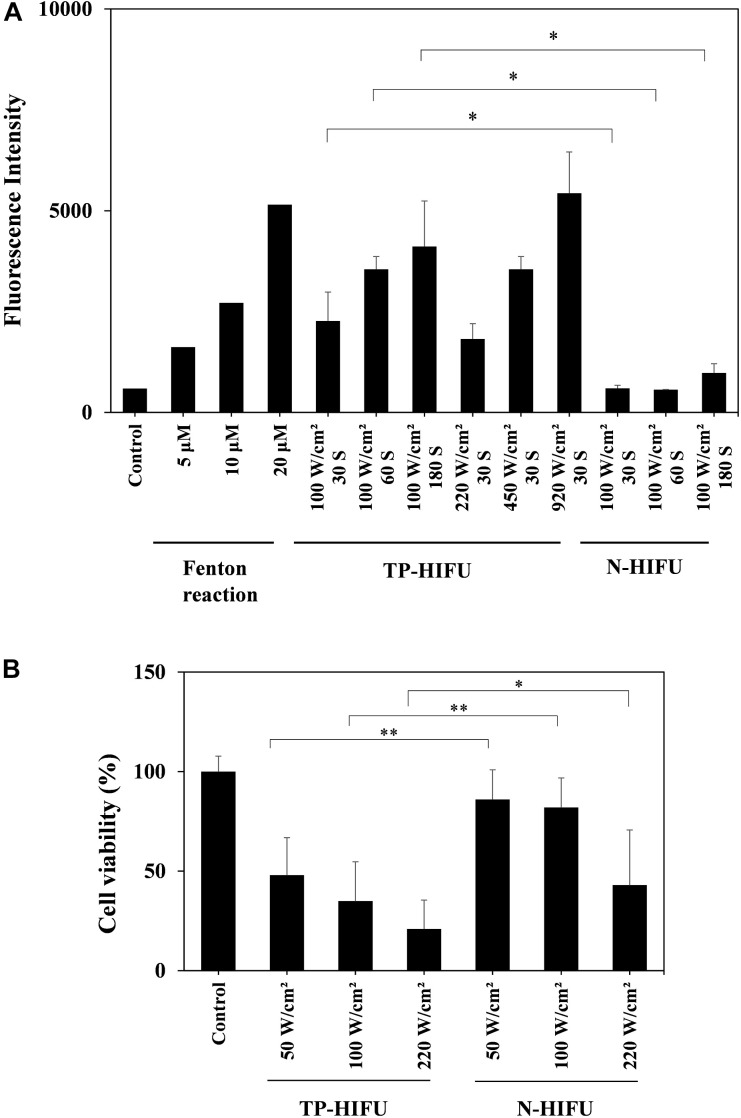
(A) Hydroxyl radical measurement by HPF method. In the Fenton reaction sample, H2O2 solution and FeSO4 solution were both added to HPF solution to final concentration of 5, 10, and 20 μM, respectively. The fluorescence intensity of the fluorescein released from HPF by hydroxyl radicals was measured with a microplate reader (ex./em. = 490/515 nm). HIFU irradiation groups were collected for five or more irradiation samples and the results are presented as the mean ± standard deviation. ∗P < 0.05 non-parametric comparison for each pair by Wilcoxon test. (B) Cell viability assay of BxPC-3 cell line. Suspension of detached BxPC-3 cells were dispensed into a 96-well microplate for HIFU irradiation. Viable-cell counting was carried out by CCK-8 method. Each group was collected for 20 or more irradiation samples and the results are presented as the mean ± standard deviation. ∗P < 0.05, ∗∗P < 0.01, non-parametric comparison for each pair by Wilcoxon test.